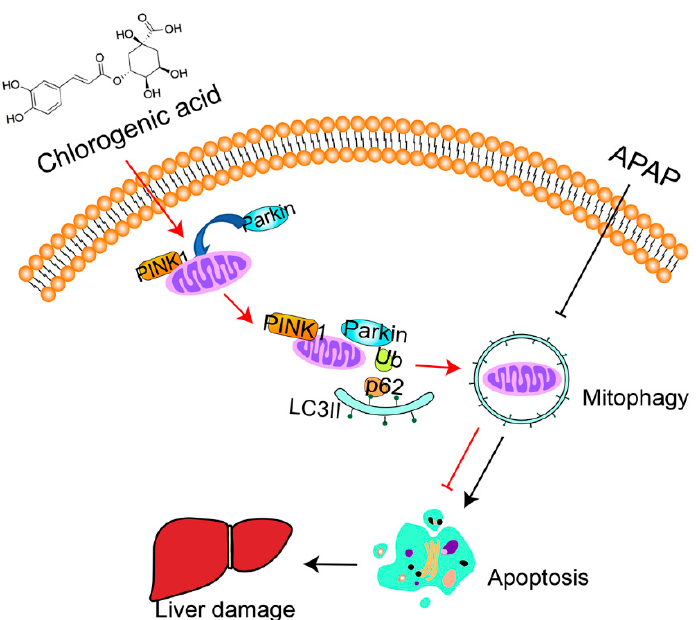
Figure 7. Graphical summary of the results. CGA protects against acetaminophen-induced hepatotoxicity in mice through activating PINK1-dependent mitophagy to inhibit apoptosis.